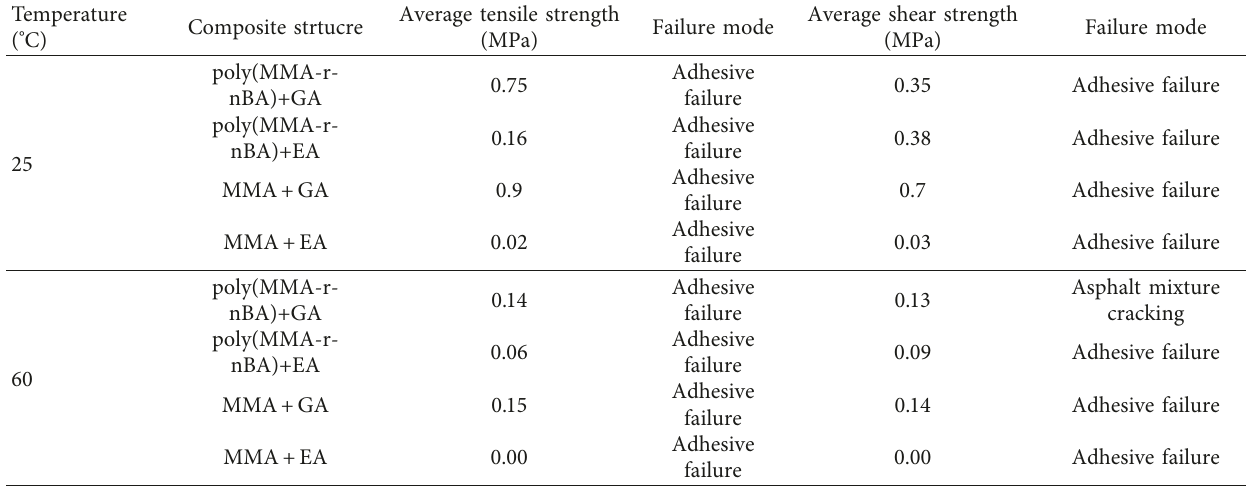
Table 4: Pull-off/shear test results of “poly(MMA-r-nBA)/MMA+asphalt mixture” composite structure at different temperatures. Temperature ( °